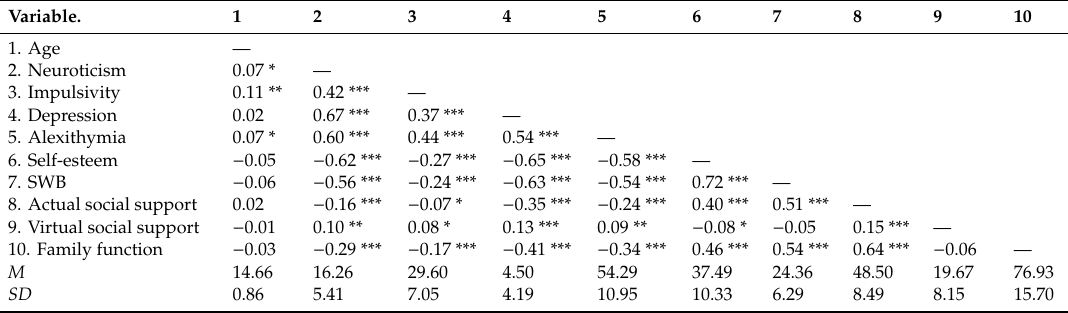
Table 2. Bivariate correlations of study